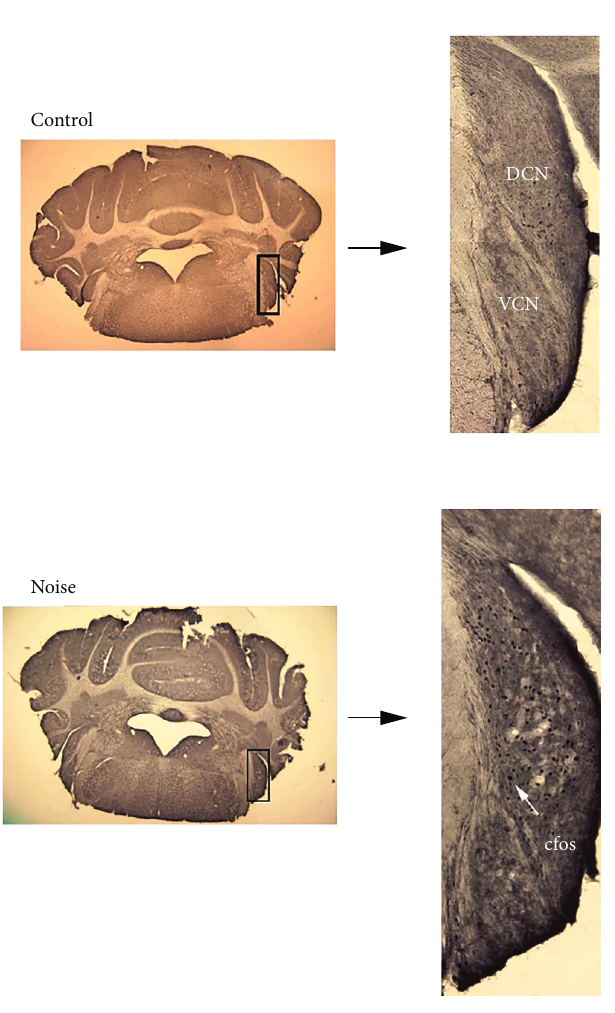
Figure 5: Comparison of c-Fos expression in the two groups of animals at the cochlea nucleus. The expression of c-Fos in the cochlea nucleus of the noise group was signi fi cantly higher than that in the control group. The expression site is mainly located in DCN. A circular black spot is c-Fos positive ( ↖